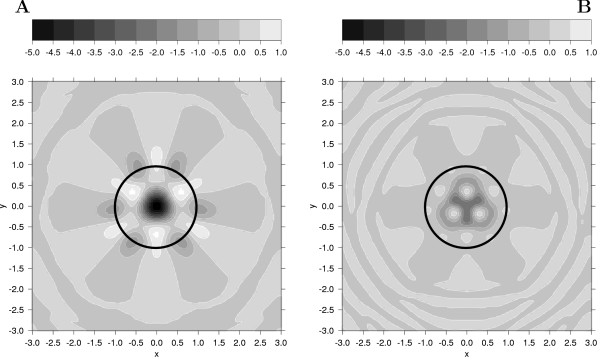
Contour plots of total intermolecular potential. Contour plots of the intermolecular potential between two coarse-grained GB particles with embedded charges in face-face arrangement on the z direction at a vertical distance of 0.45 σ0 and twisted of 60° (A: GB+HT-T charges, B: GB+HT-AT charges). The first particle, whose extension is rendered as a black circle, is kept fixed at the origin, while the second is displaced in the xy plane.